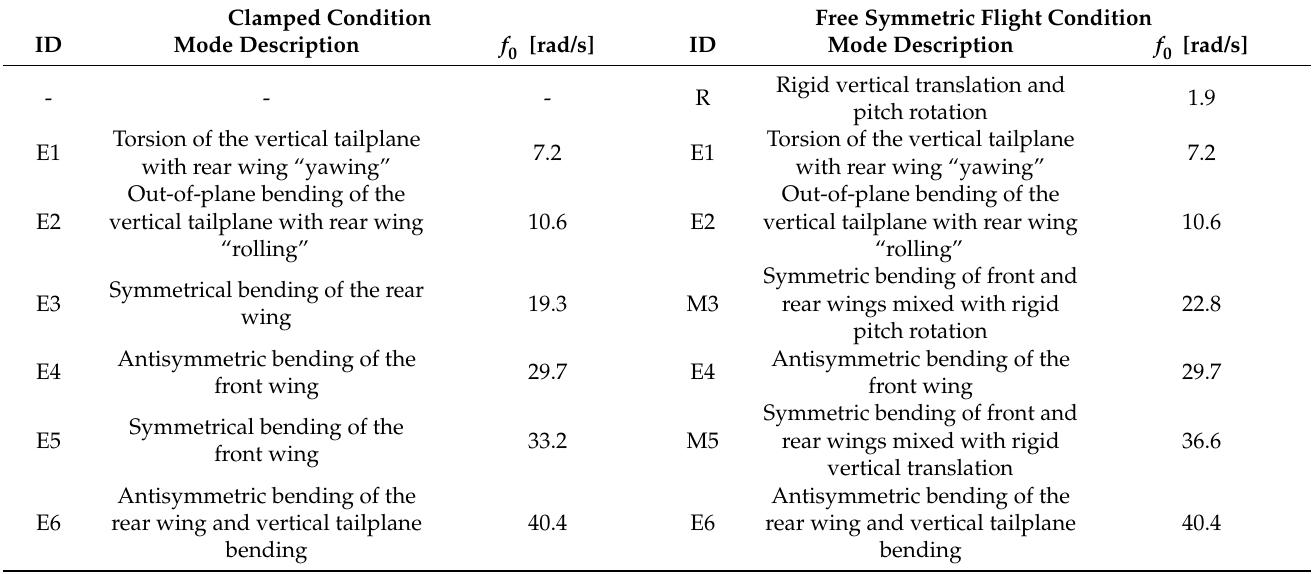
Table 7. First modes observed in the flutter analysis of the tandem-wing architecture (R: mostly rigid; E: mostly elastic; M: mixed